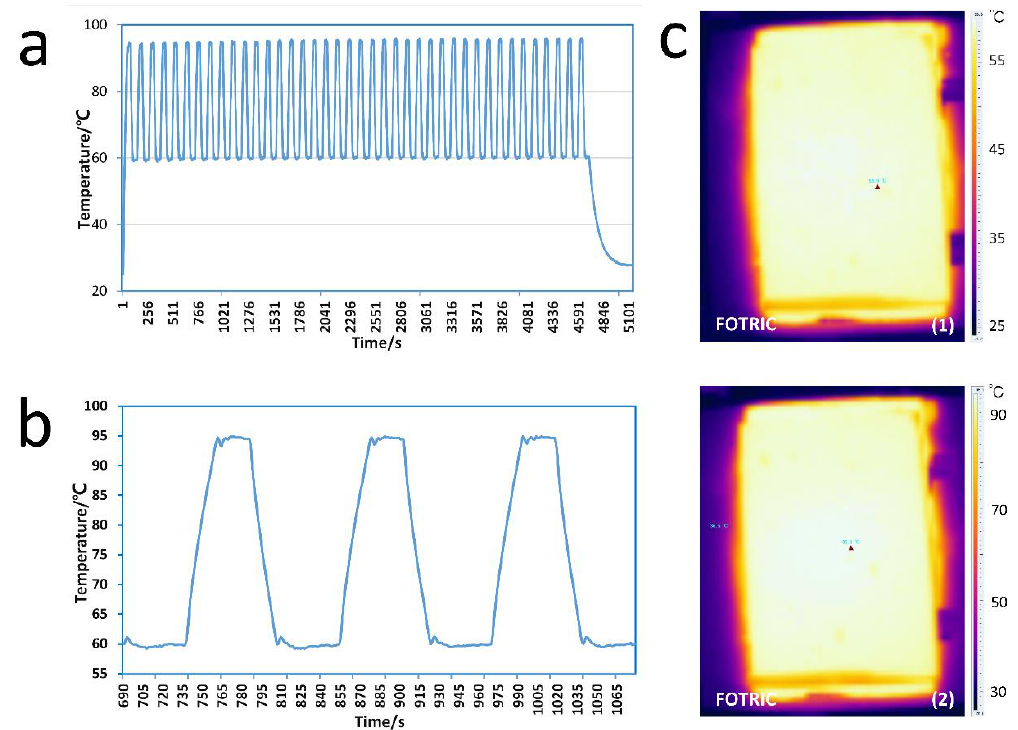
Figure 3. ( a ): Temperature change during PCR. ( b ): Temperature change over two cycles. ( c ): Infrared image of the upper surface of the glass at (1) 60 °C and at (2) 95 °C .